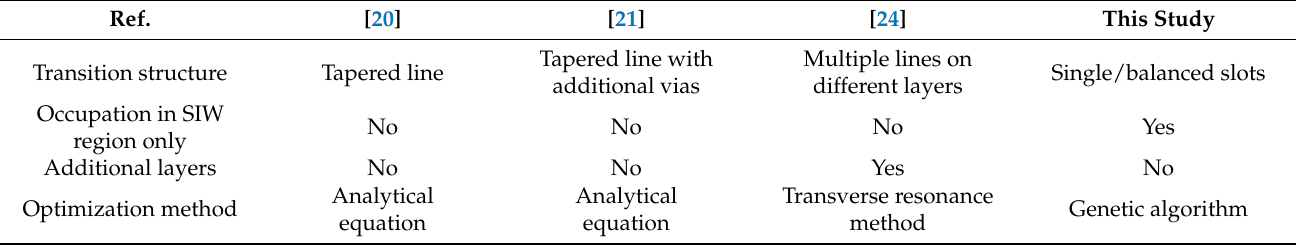
Table 2. Comparison of transition technique for SIWs.